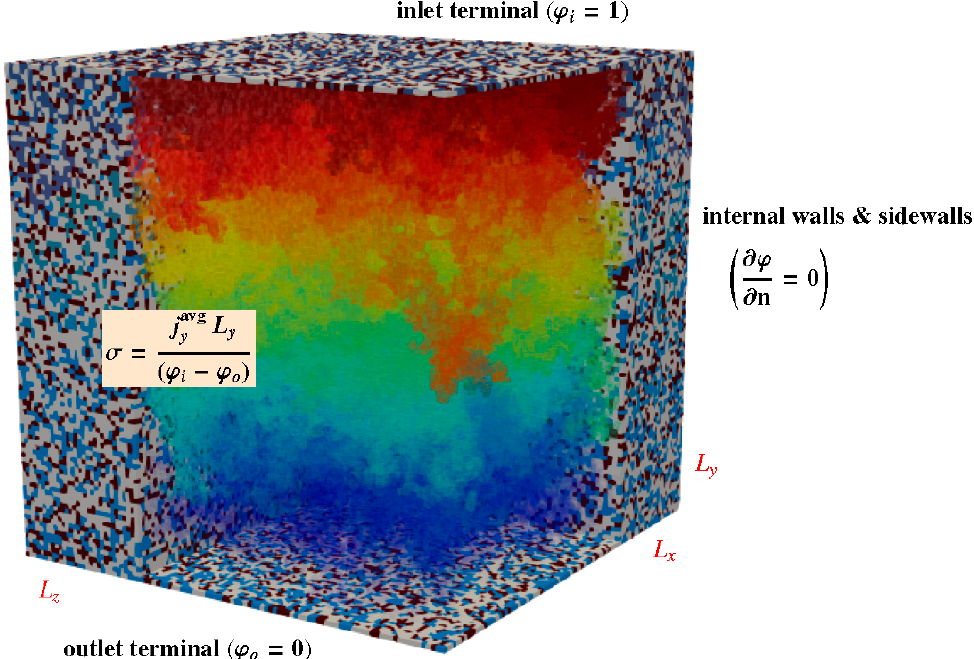
Figure 4. Schematic of the computational domain, showing the generated mesoscopic membrane structure and the computed ionic potential distribution, ϕ ( x , y , z ) , across the hydrated, conductive network. The boundary conditions, the dimensions of the domain, and the expression used to calculate the global ionic conductivity of the network, σ , are indicated. Blue sites correspond to hydrated sulfonated sites, gray sites to weakly hydrated or non-hydrated sulfonated sites, and brown sites to dry weakly sulfonated sites.